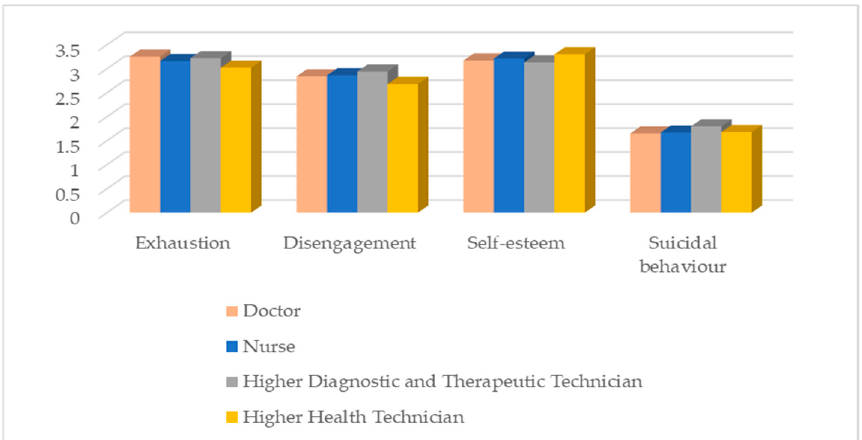
Figure 3. Distribution of the variables under study according to profession .